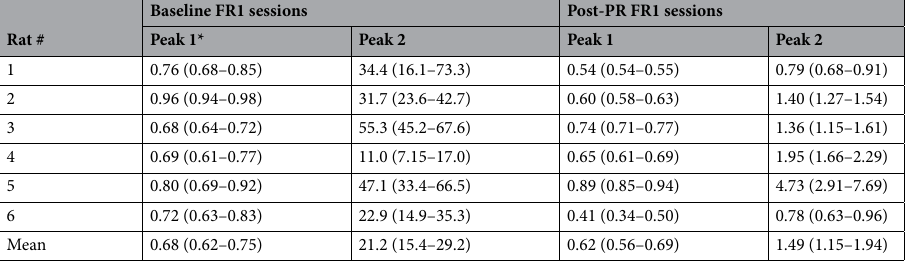
Table 1. Peaks of the lognormal distributions of IPIs during unloading phases of cocaine self-administration sessions under the FR1 schedule before and after sessions under the PR schedule in individual rats. *Peaks represent the most frequent IPIs in seconds for both modes of the distribution. The range of standard errors is in